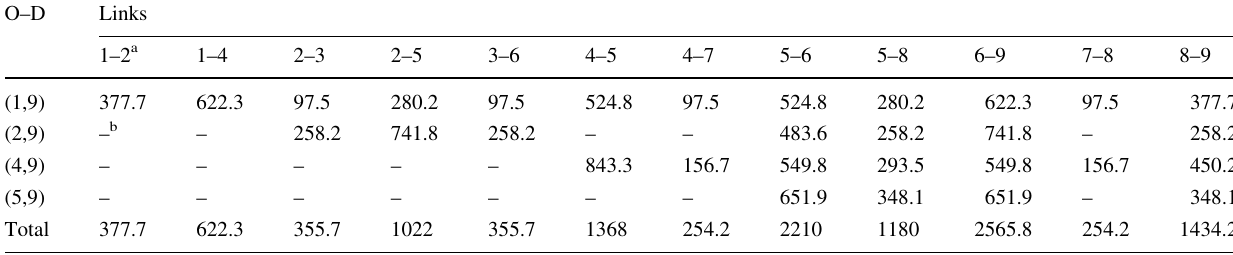
Table 2 Link flow assigned by O–D pairs and total link flow by the logit–weibit hybrid model